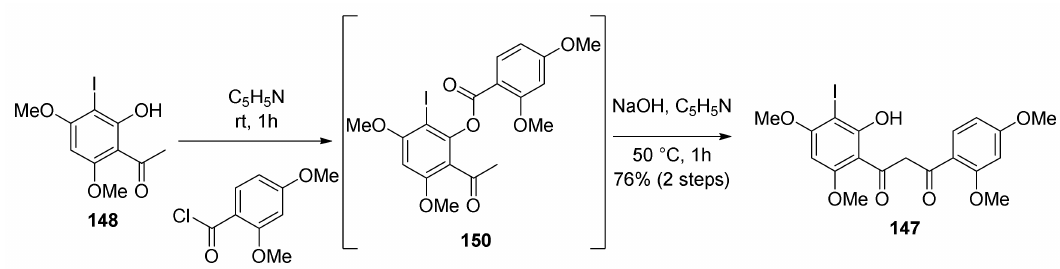
Figure 49. Preparation of iodo- β -diketone 147 .